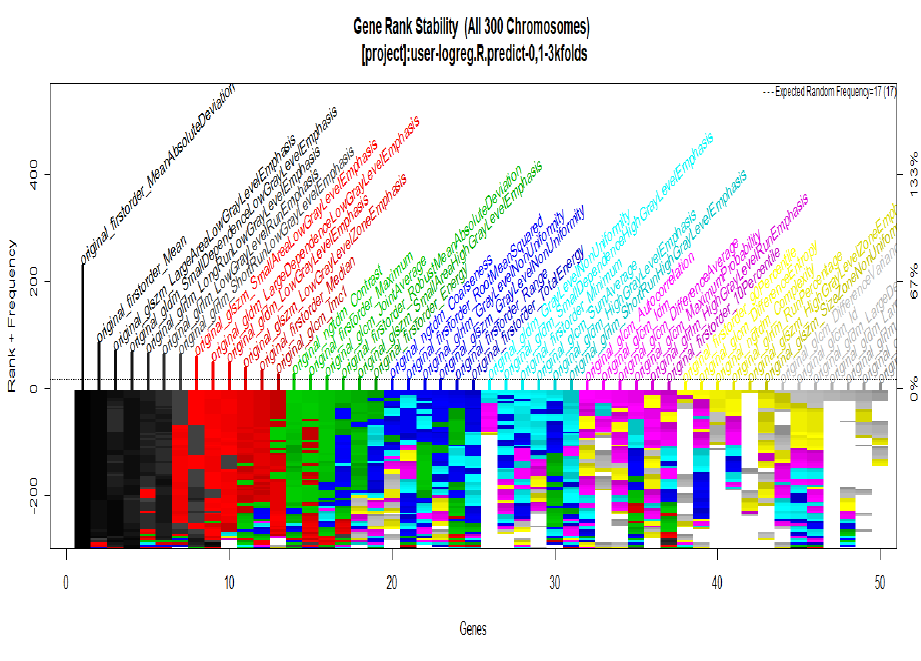
Figure 12. Gene Rank Stability graph with calcification model by radiologist segmentation; the gene rank shows the stability of the top-ranked 50 variables. The horizontal axis shows the genes ordered by rank, and the vertical axis shows the gene frequency. The bottom color—coded rank represents the genetic stability, where features with no change in color represent a stable feature; changing color features represent unstable